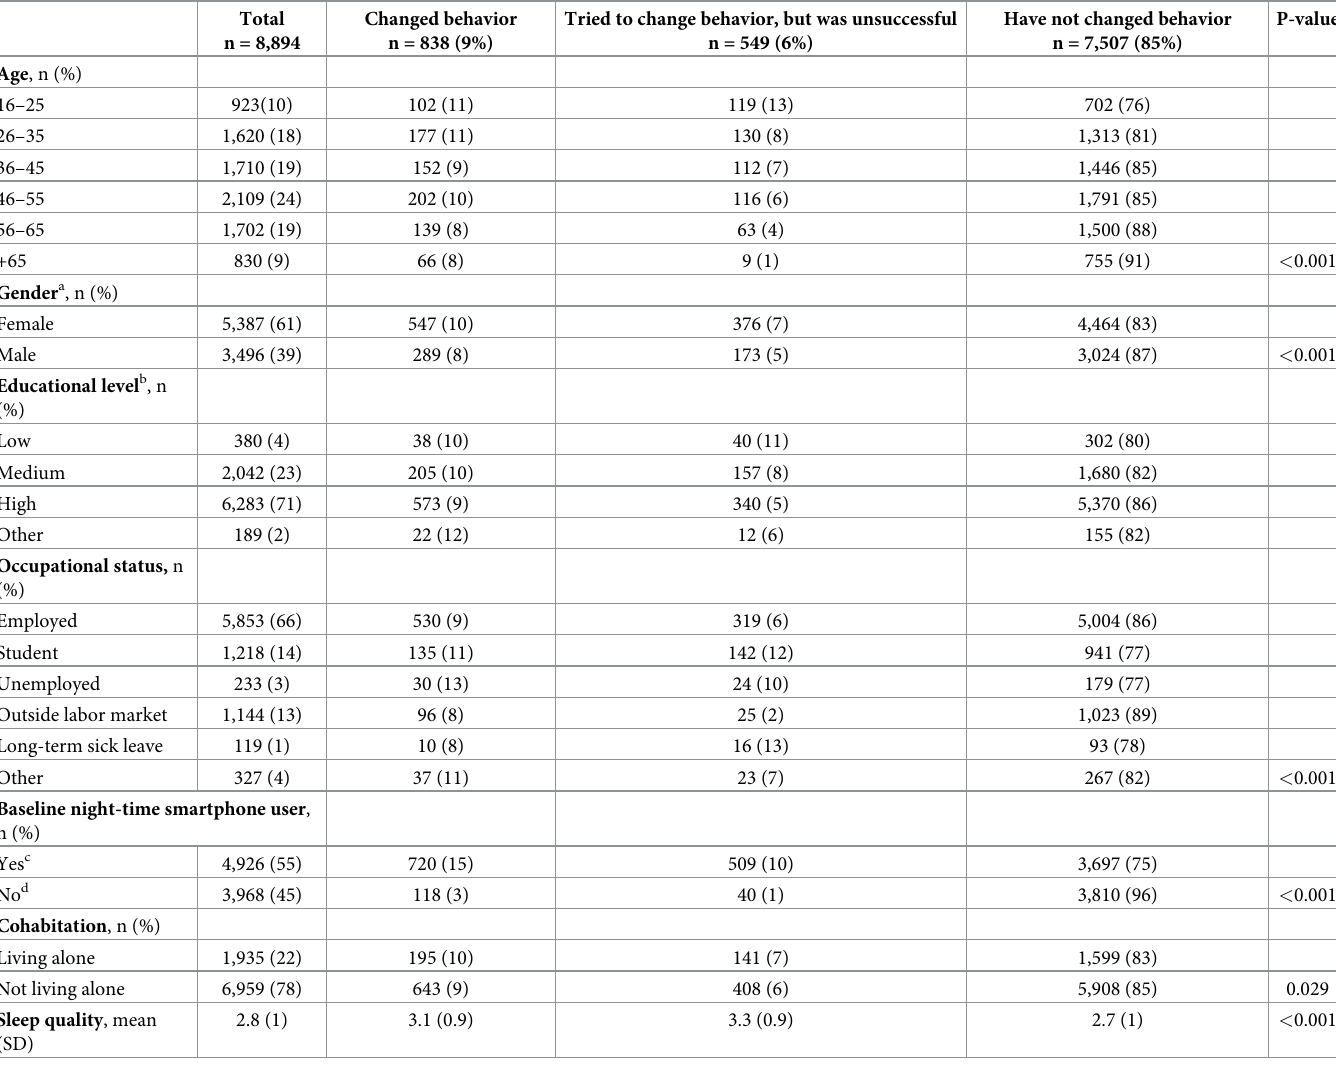
Table 1. Characteristics of the study population according to changed night-time smartphone behavior among 8,894 participants in the SmartSleep Experiment